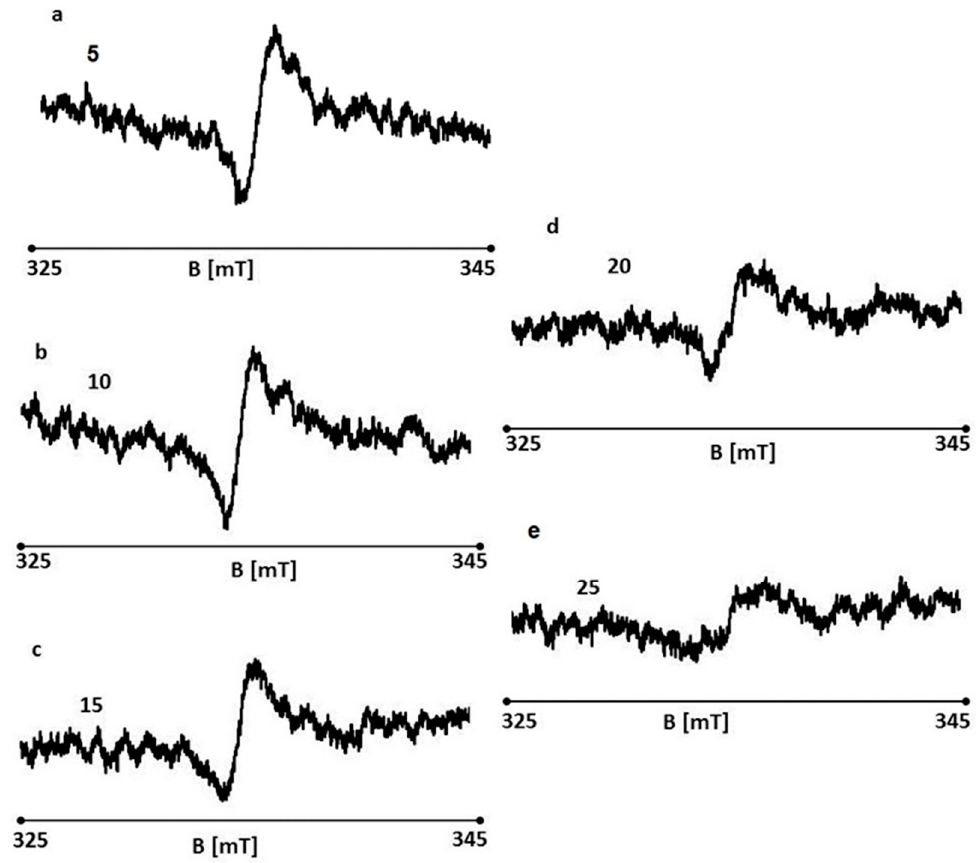
Figure 30. EPR spectra of burn wounds treated with the 1% nanosilver ointment on days 5 ( a ), 10 ( b ), 15 ( c ), 20 ( d ), and 25 ( e ) of the treatment.